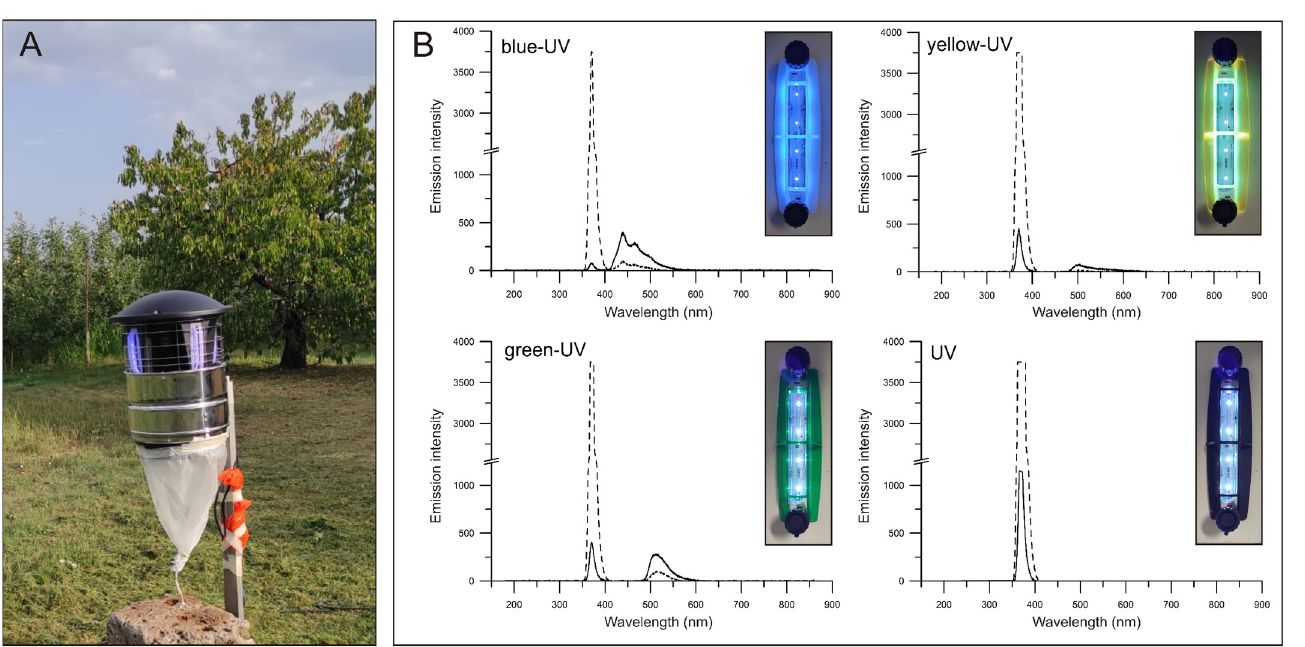
Figure 1. Overview of a multimodal electric trap used in field experiments ( A ). Emission intensity of single lamps emitting blue-UV, green-UV, yellow-UV, or UV only wavelengths were evaluated in laboratory conditions and are reported in arbitrary scale ( B ). For each combination of lamp and plastic grid, the emitted radiation flux was measured at close contact (continuous line) or at 2 cm distance (dashed line).